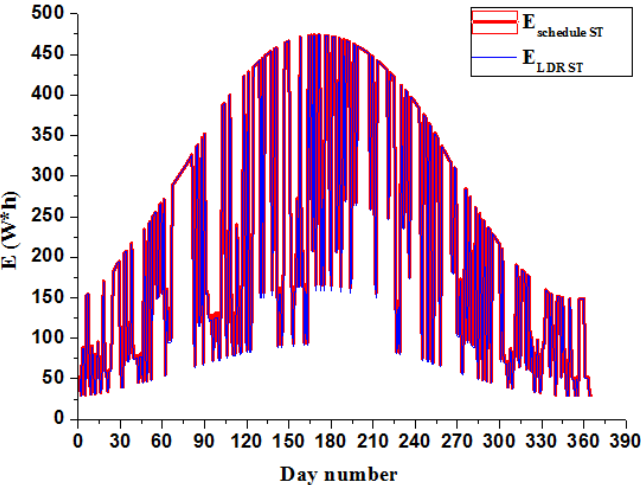
Figure 14. Calculated annual solar radiation under ideal conditions and weather conditions.